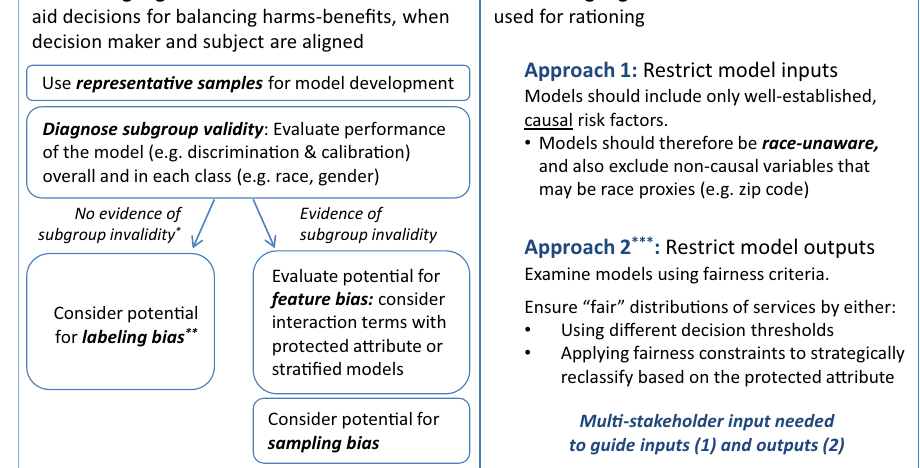
Fig. 3 Mitigating algorithmic bias and unfairness in clinical decision-making. Bias arises through differential model performance across protected classes, such as across racial groups. a It is a concern in both polar and non-polar decision contexts and can be addressed by “ debiasing ” predictions, typically through the explicit encoding of the protected attribute to ameliorate subgroup validity issues, or by the more thoughtful selection of labels (in the case of labeling bias). Fairness concerns are exclusively a concern in polar decision contexts, and may persist even when prediction is not biased. b There are two broad and fundamentally very different unfairness mitigation approaches: (1) an input-focused approach, and (2) an output-focused approach (Fig. 3b). The goal of the input-focused approach is to promote class-blind allocation by meticulously avoiding the inclusion of race or race proxies. The output-focused approach evaluates fairness using criteria such as those described in Table 1 and Fig. 1. Fairness violations can be (partially) addressed through the use of “ fairness constraints ” (which systematically reclassify participants/patients to equalize allocation between groups) or by applying different decision thresholds across